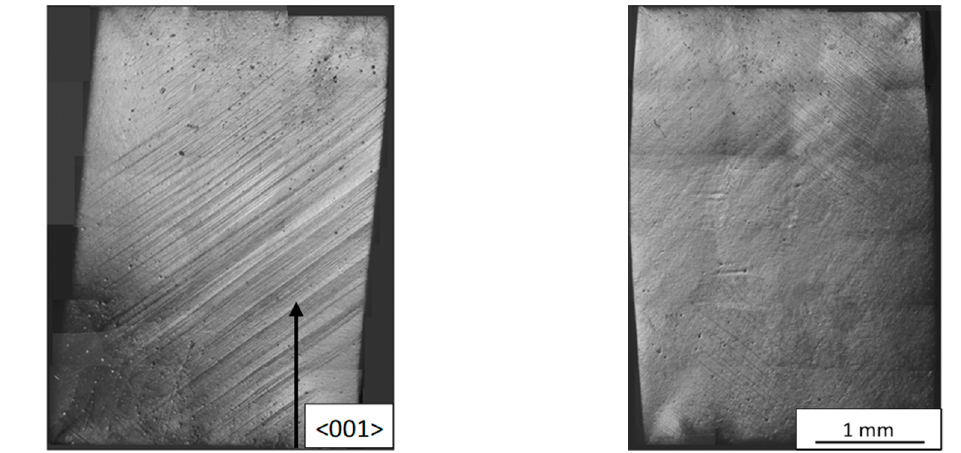
Figure 15. Deformation patterns on neighboring {100} lateral faces of a < 001 > Ni single crystal with h / d = 2. Compression was carried out along the < 001 > axis; ε = 22%.